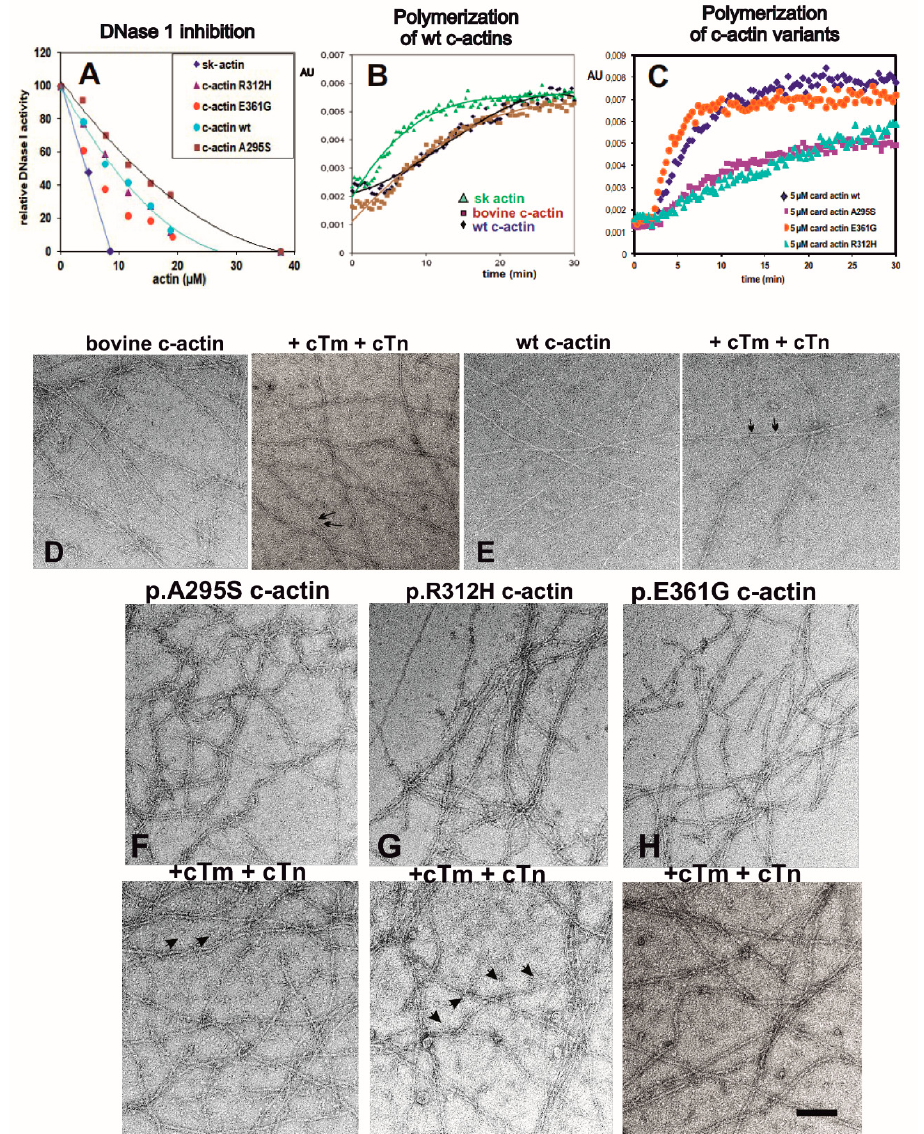
Figure 2. Properties of the purified c-actins indicating native state. ( A ) Inhibition of DNase I activity as measured by the hyperchromicity assay. Human DNase I (0.1 mg/mL = 3.22 µ M) was mixed with the amounts of c-actins indicated in the abscissa. DNase activity was determined as detailed [26]. Ordinate gives the relative remaining activity calculated. ( B ) Comparison of the rates of polymerization of purified sk-actin and bovine c-actin purified from acetone powders with recombinant wt c-actin, each at 5 µ M. Note the faster polymerization rate of sk-actin and the equal rates of c-actins. Polymerization was initiated after the addition of 2 mM MgCl 2 at t = 2 min and determined by the pyrene-assay using 0.5 µ M pyrene-labeled skeletal muscle actin (see Materials and Methods). ( C ) Polymerization of the cardiac actin variants: recombinant wt-c-actin, p.A295S, p.R312H, and p.E361G (all c-actins at 5 µ M; for details see text). ( D – H ) Electron microscopy after negative staining of the polymerized c-actins before and after decoration with cTm/cTn: ( D ) bovine and ( E ) wt recombinant c-actin. ( F ) p.A295S, ( G ) p.R312H, and ( H ) p.E361G mutant. Bar in ( H ) corresponds to 100 nm (applicable to all